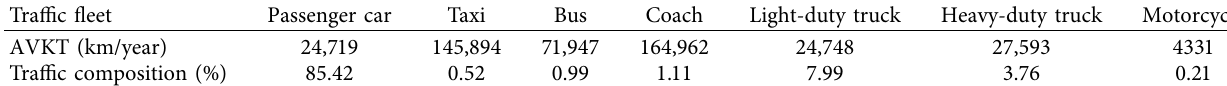
Table 8: Annual vehicle kilometers traveled.